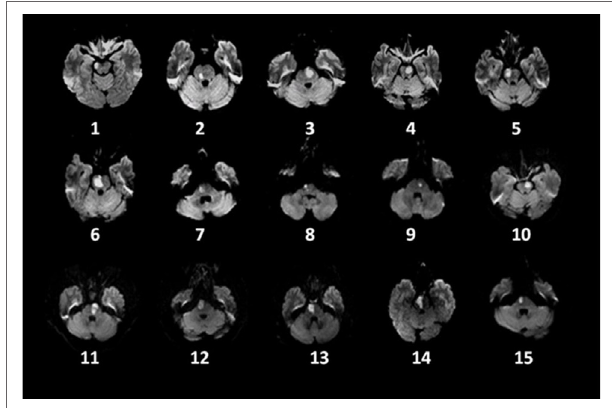
FigUre 1 | Distribution of lesions on diffusion-weighted imaging in 15 patients with pontine infarction.